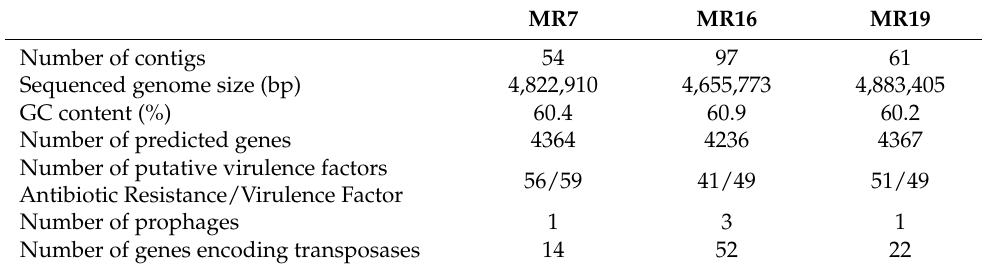
Table 1. Characteristics of Aeromonas sp. MR7, MR16, and MR19